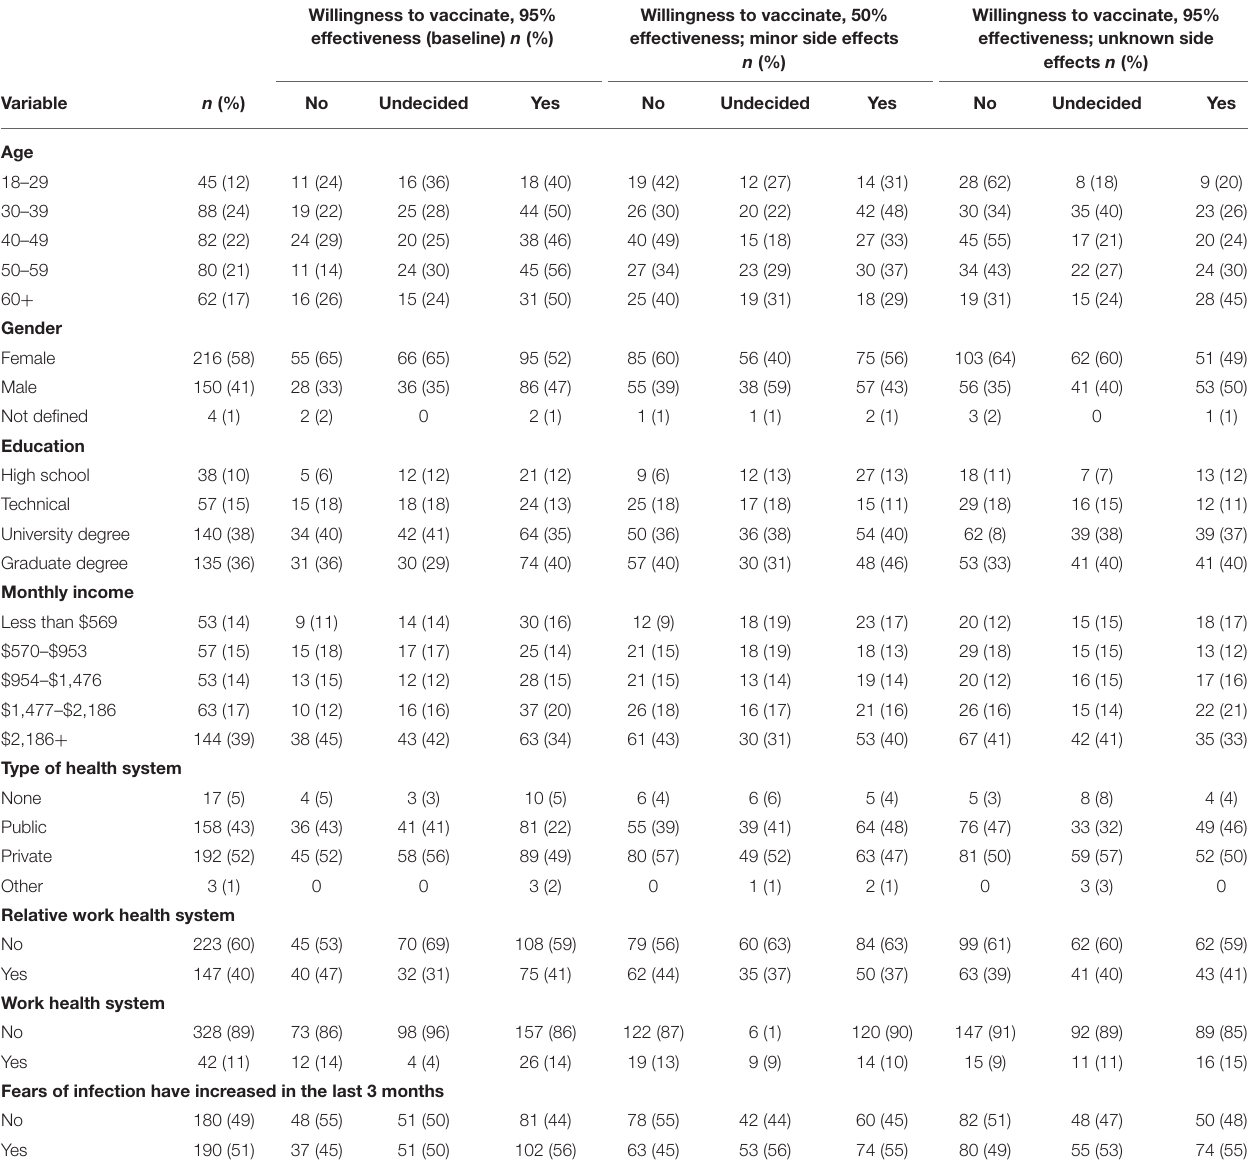
TABLE 1 | Sociodemographic data for three scenarios regarding a hypothetical vaccine against COVID-19.